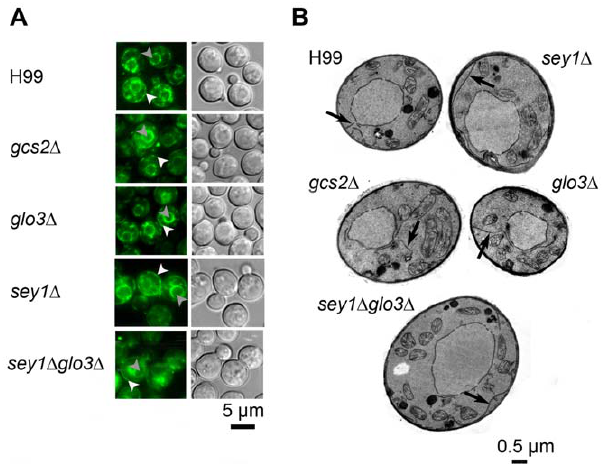
Figure 7. Disruption of SEY1, GCS2 and GLO3 causes ER elongation. A ) A GFP fusion of the ER protein Sec61 b p was expressed in each indicated strain. Cells from fresh overnight culture grown on YPD agar at 30 u C were visualized under a florescent microscope. White arrow head=ER; grey arrow head=nucleus (determined by co-localized Hoechst 3342 dye staining; Figure S4). B ) Transmission Electron Microscopy (TEM) of each deletant and the wild type cells. Cells were grown overnight on a shaker at 30 u C in YPD broth to mid log phase and cells were prepared for and examined by TEM.